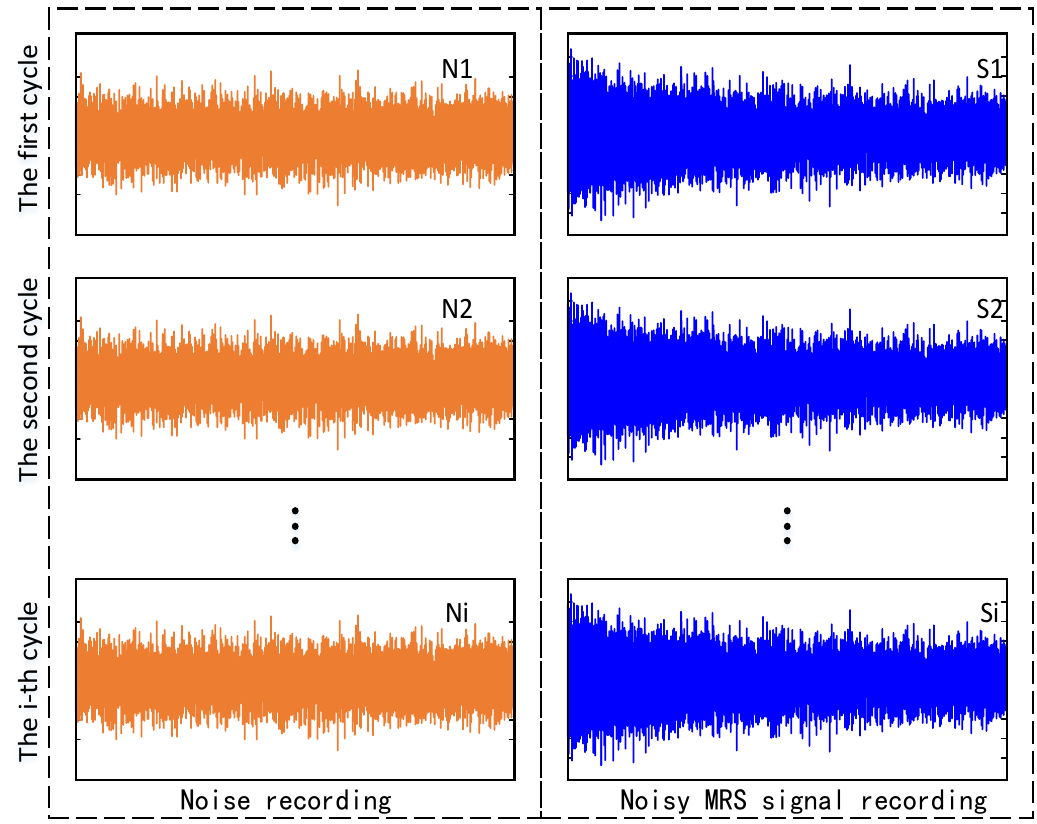
Figure 1. Schematic diagram of the magnetic resonance sounding (MRS) data acquisition procedure for data acquisition and multi-frame spectral subtraction (DA-MFSS).